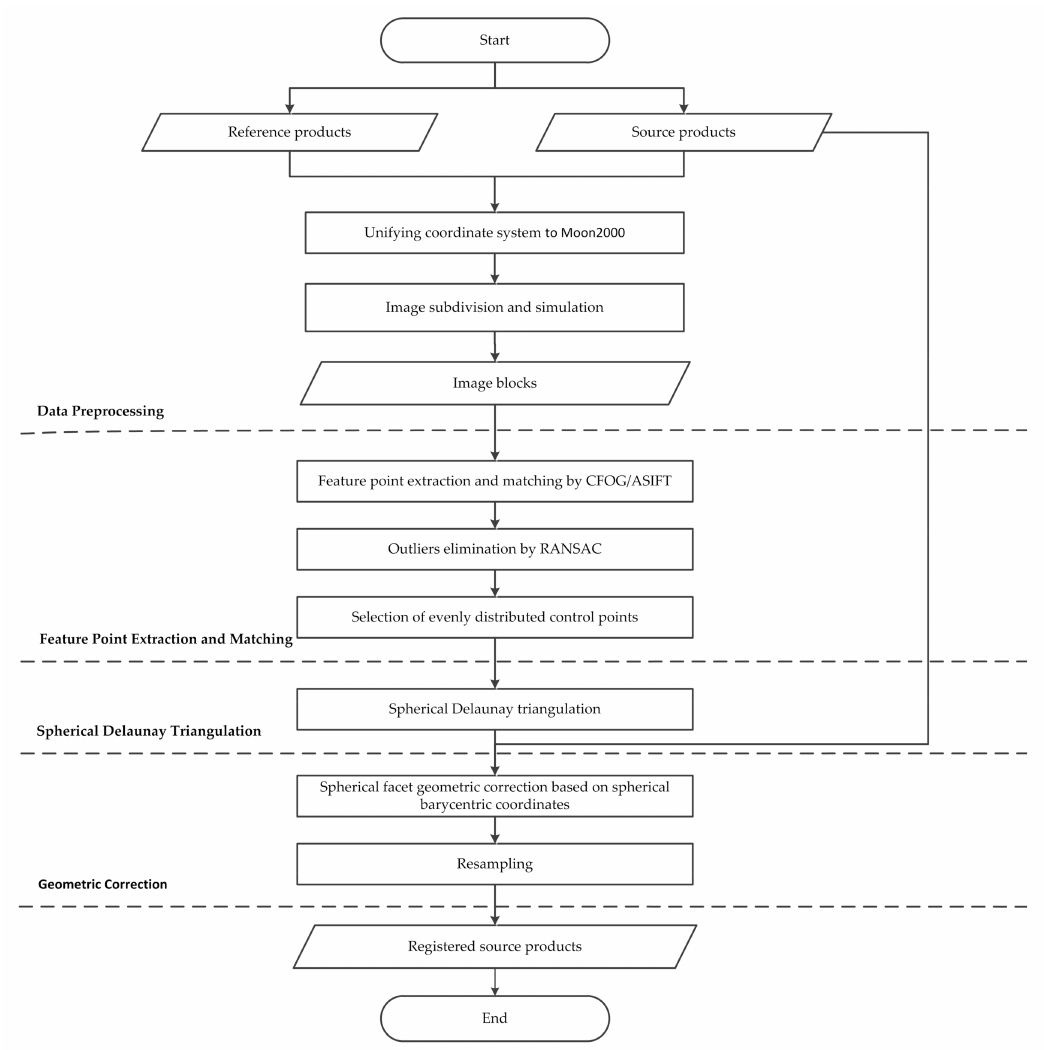
Figure 1. Overall flowchart of the proposed